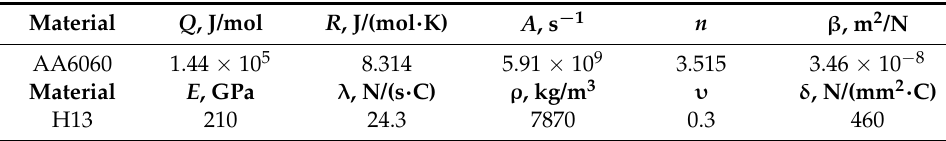
Table 2. Material parameters of AA6060 and